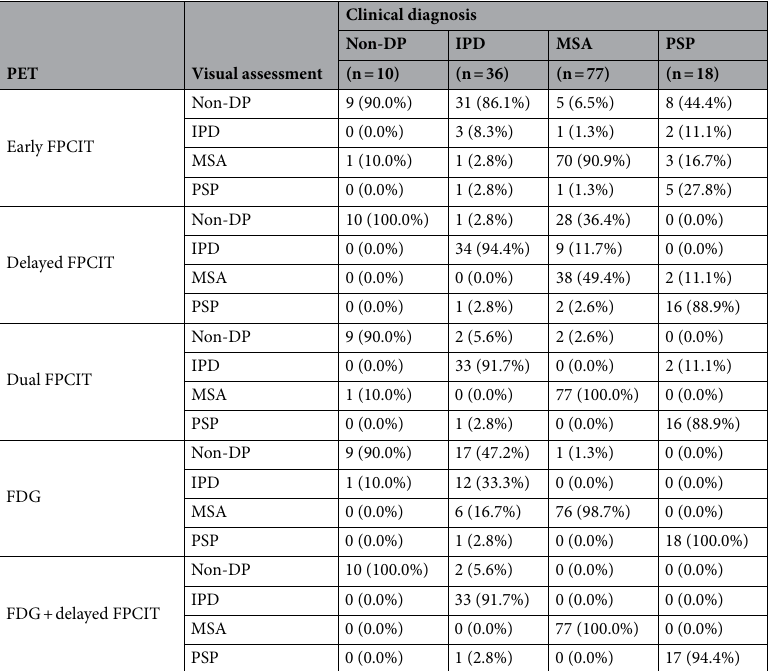
Table 2. Classification matrix of visual assessment of PET scans compared to clinical diagnosis.